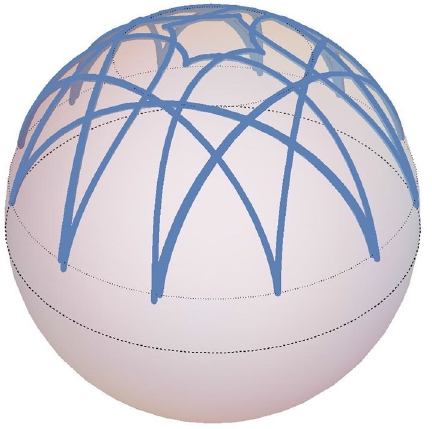
Fig. 16 An infinite closed string with exact periodicity conditions and δϕ = 2 π/ 3 and 2 Δϕ = π/ 2. The seed solution has a rotating static Pohlmeyer counterpart with E = 6 μ 2 / 5. Four patches of the original seed string solution are required to form the dressed string δσ = 2 ω /(γβ) and δσ = 2 ω /γ , for translationally 0 1 1 1 invariant and static seeds, respectively. This implies that a closed string, which is covered by σ 1 ∈ [ Σ 0 , Σ 0 + ΔΣ)